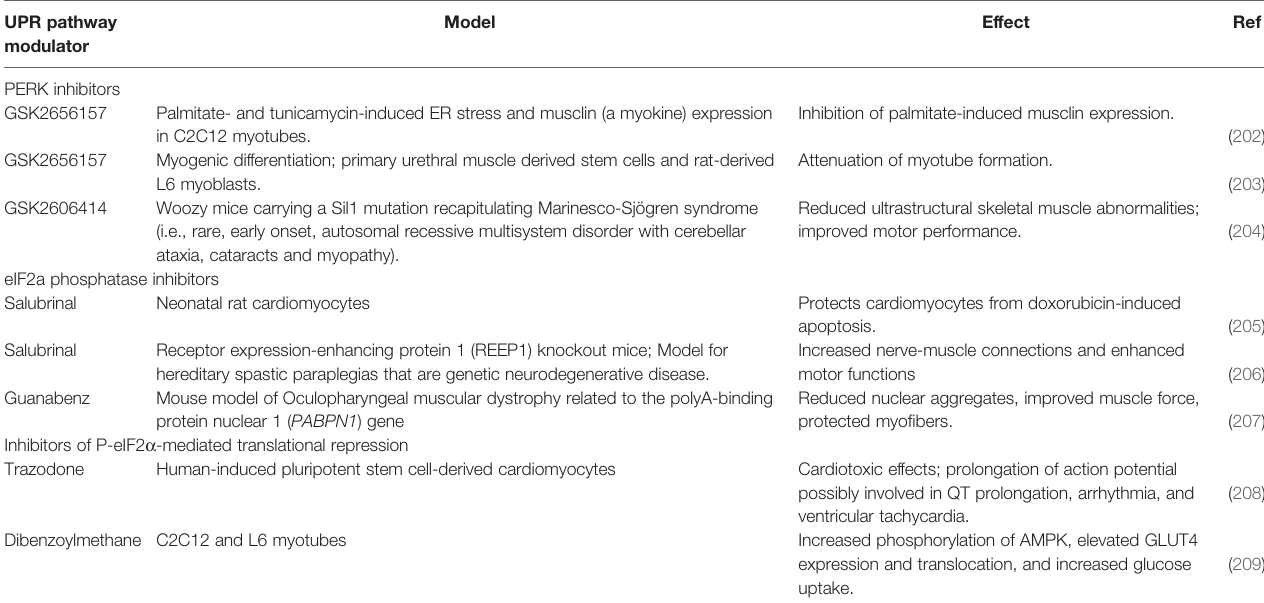
TABLE 1 | Effects of UPR pathway